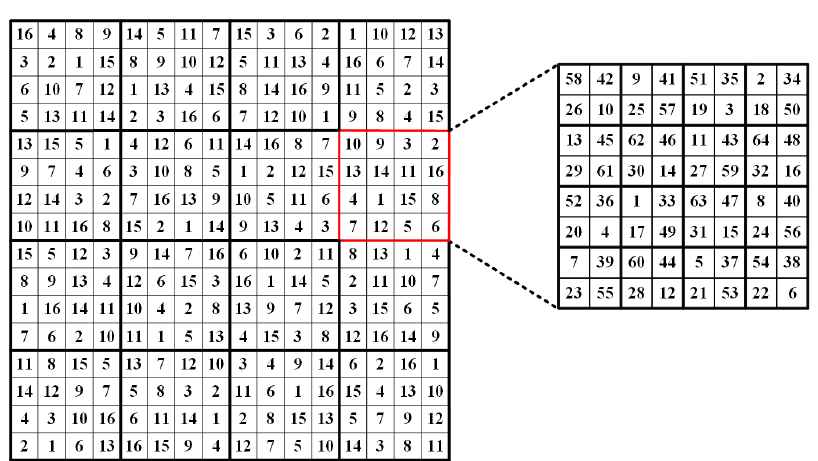
Figure 16. Diagram of the scheme for 6-bit unary